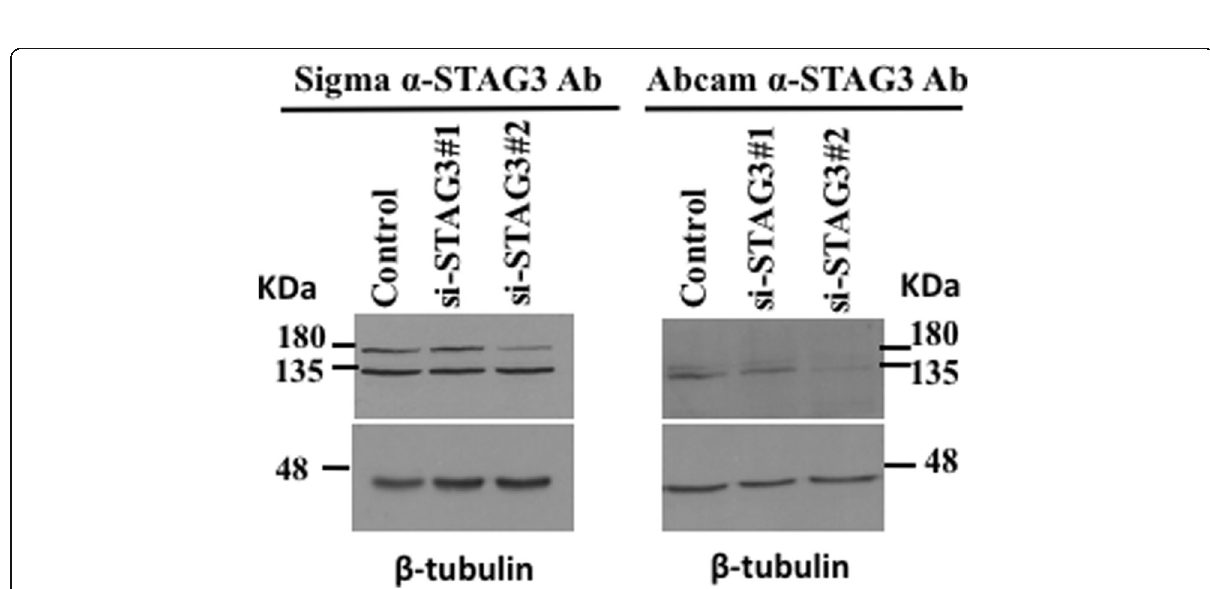
Fig. 3 STAG3 knockdown in MCF-7 cells using specific si-STAG3. To help identify which band represented STAG3, lysates of MCF-7 cells already transfected with scrambled (control) siRNA, si-STAG3#1, or si-STAG3#2 were run on SDS-PAGE and then Western blotted. The labeled bands represent the putative STAG3